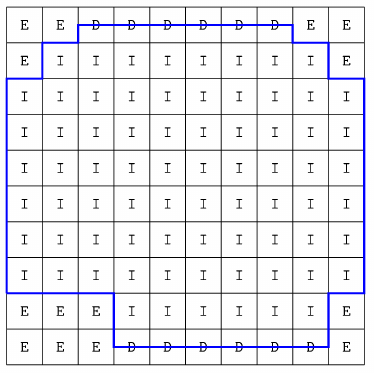
Figure 2. Domain code example in a 2D domain: I , E and D codes correspond, respectively, to internal, external and prescribed-head (Dirichlet boundary conditions) cells; the blue line denotes the border of the